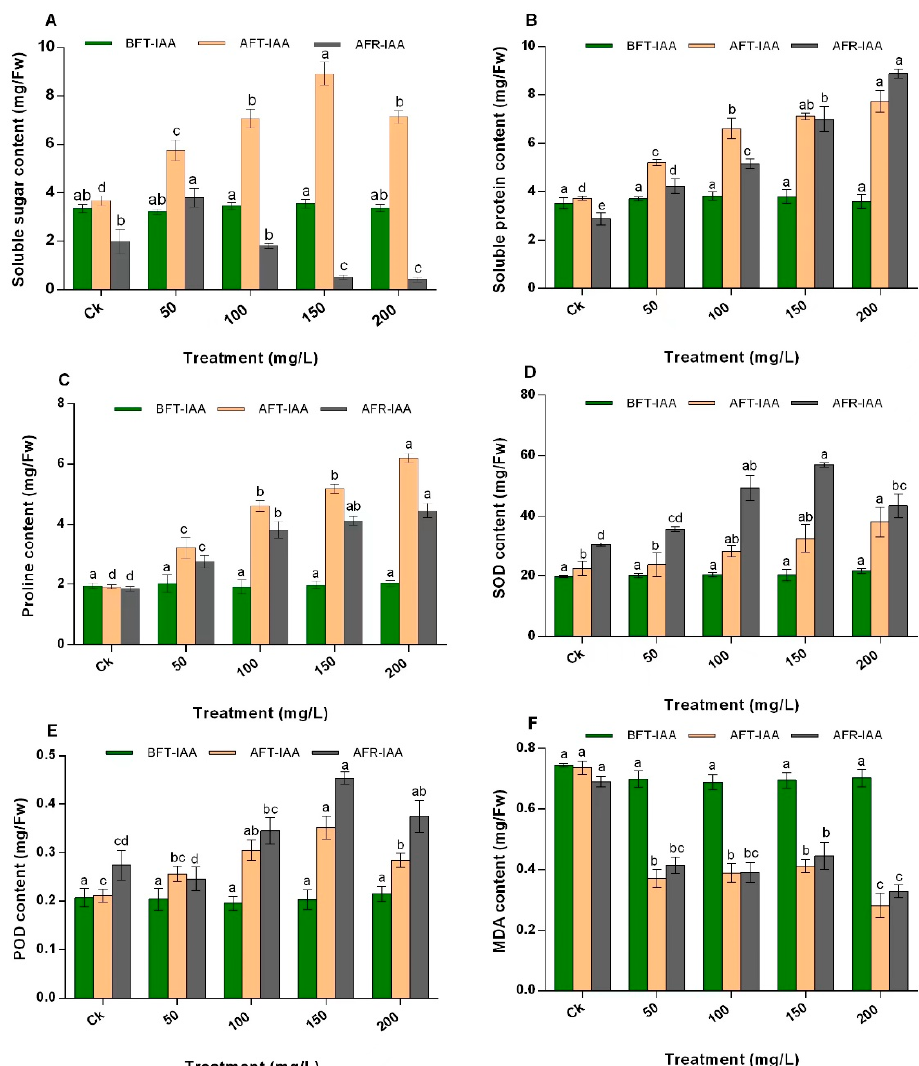
Figure 1. Effect of IAA on the ( A ) soluble sugar content, ( B ) soluble protein content, ( C ) proline content, ( D ) SOD activity, ( E ) POD content, and ( F ) MDA content of N. tangutorum . The values represent the mean of three replicates determinations. The error bars represent standard deviations. Bars with the same letter are not significantly ( p > 0.05) different.